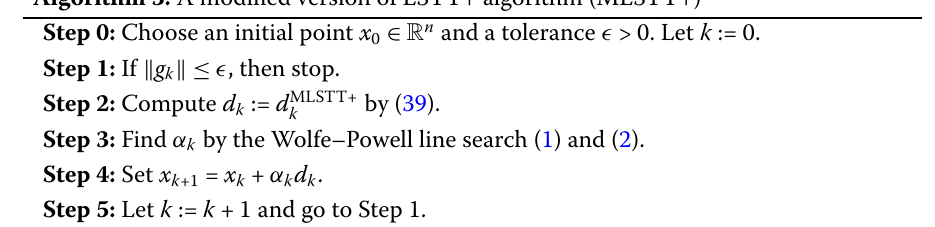
Algorithm 3: A modified version of LSTT+ algorithm